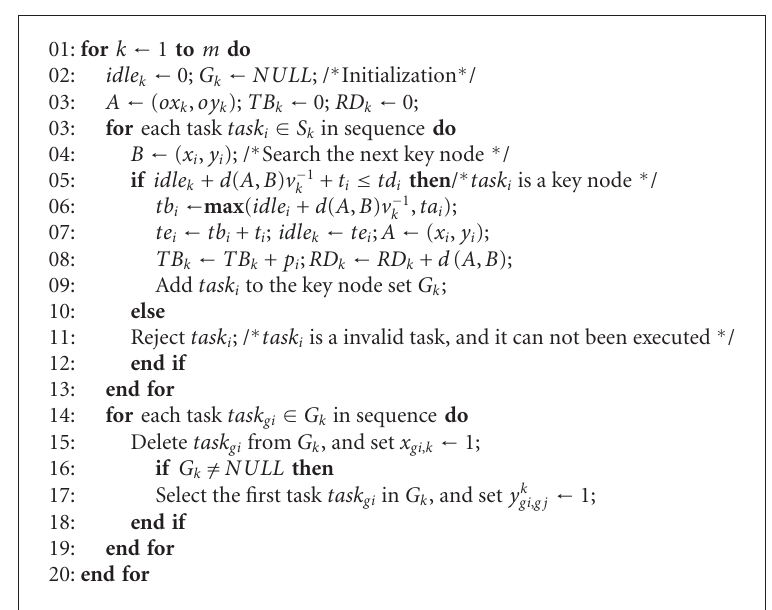
Algorithm 2: Pseudocode of KNSA